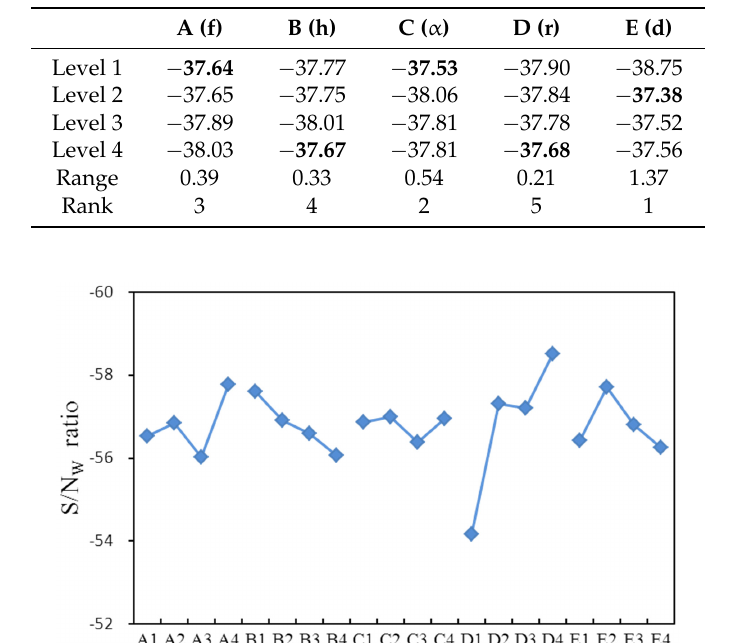
W ratios over five factors (A–D) and four levels (1–4).